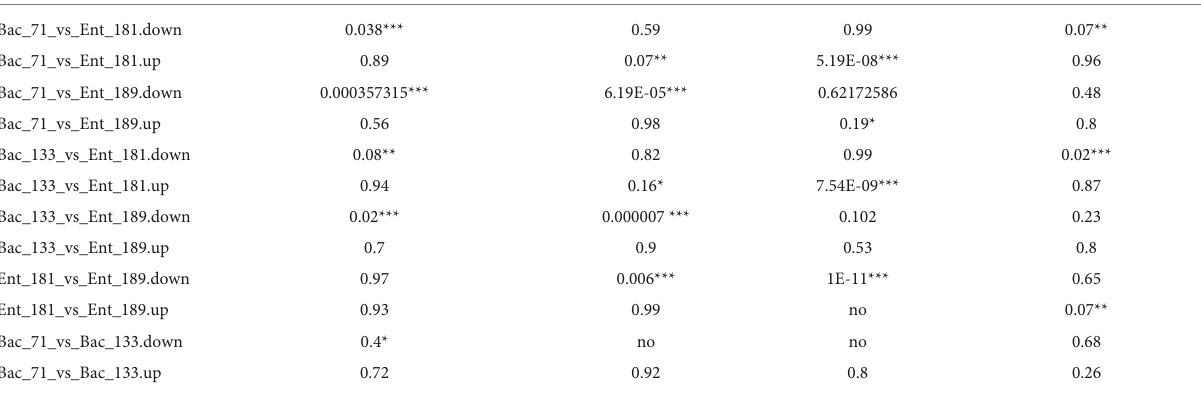
TABLE 3 The identified differential expression level for the KEGG pathway using transcriptomic